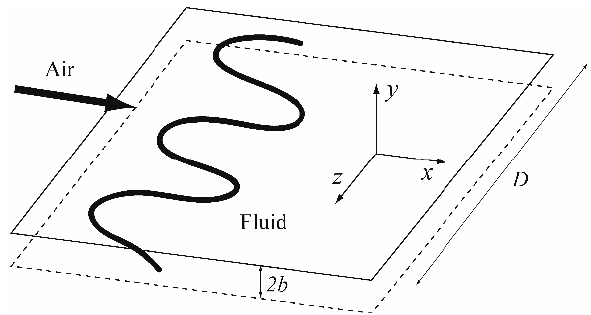
Figure 2. Scheme of main flow characteristics in a Hele–Shaw cell for a destabilized interface (thick line).